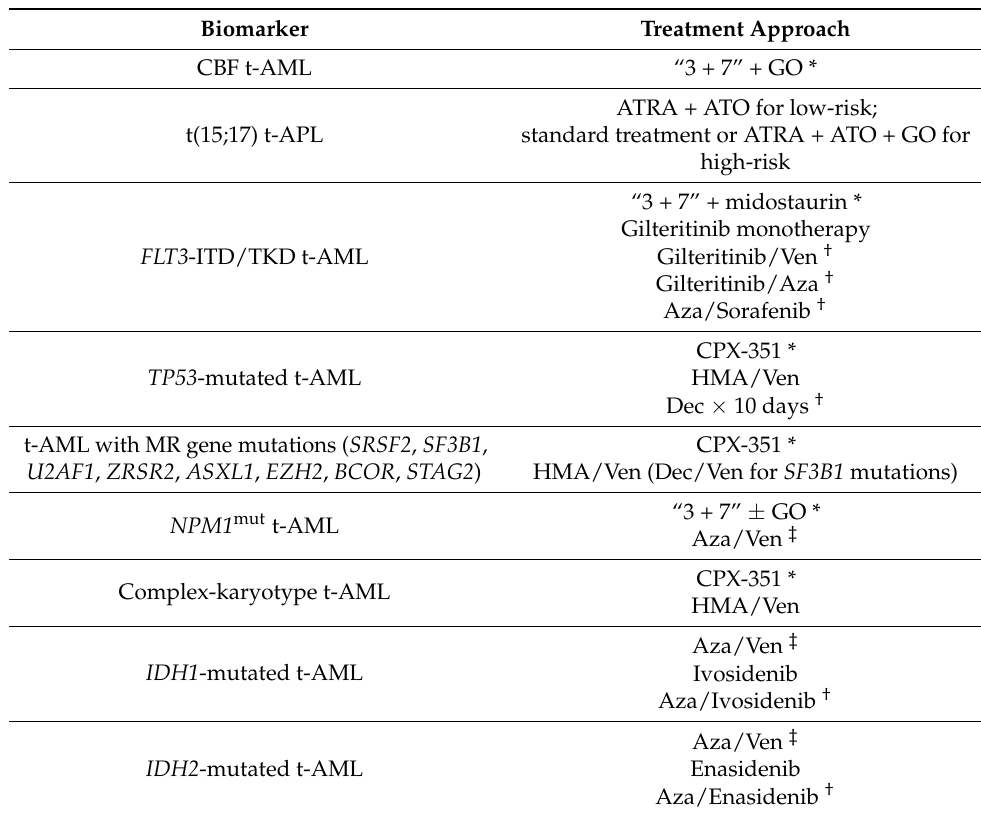
Table 3. Biomarker-driven treatment approaches for patients with t-AML.